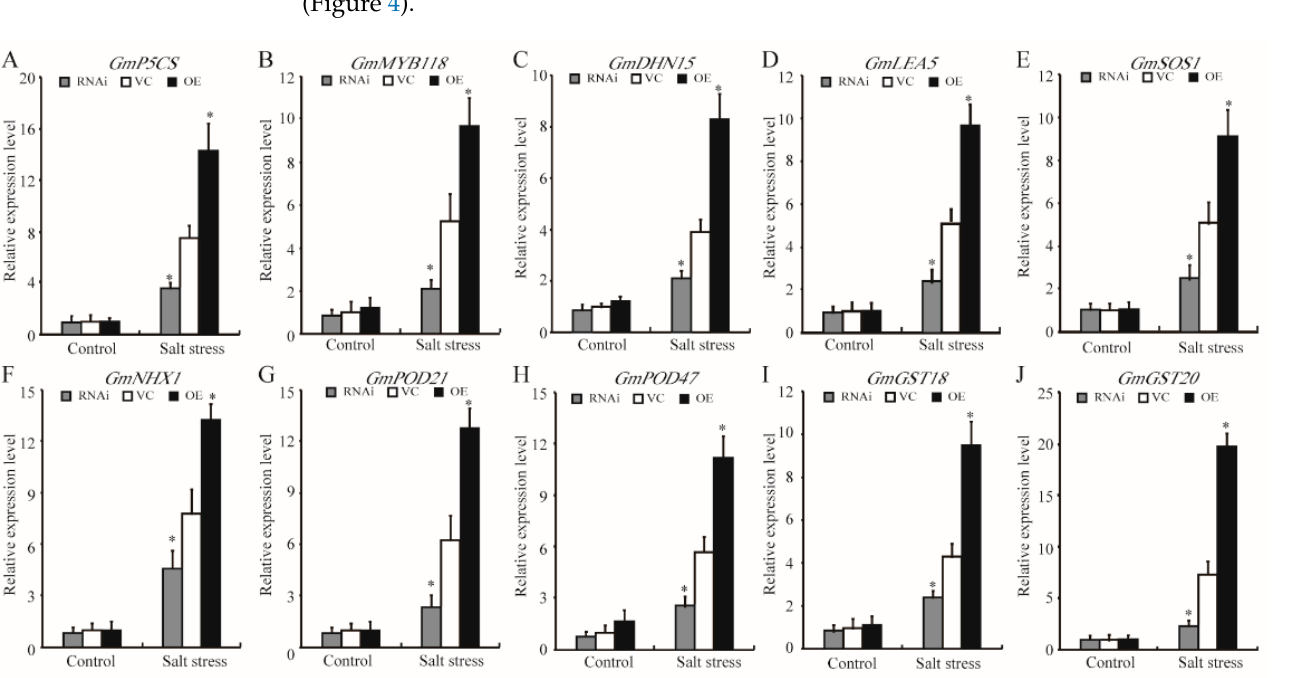
Figure 4. GmCIPK2 enhances transcripts of stress-related genes regulated by GmCIPK2 . Transcript levels of ( A–F ) salt-responsive gene ( GmP5CS , GmMYB118 , GmDHN15 , GmLEA5 , GmSOS1 , and GmNHX1 ) and ( G–J ) antioxidant-related genes ( GmPOD21 , GmPOD47 , GmGST18 , and GmGST20 )